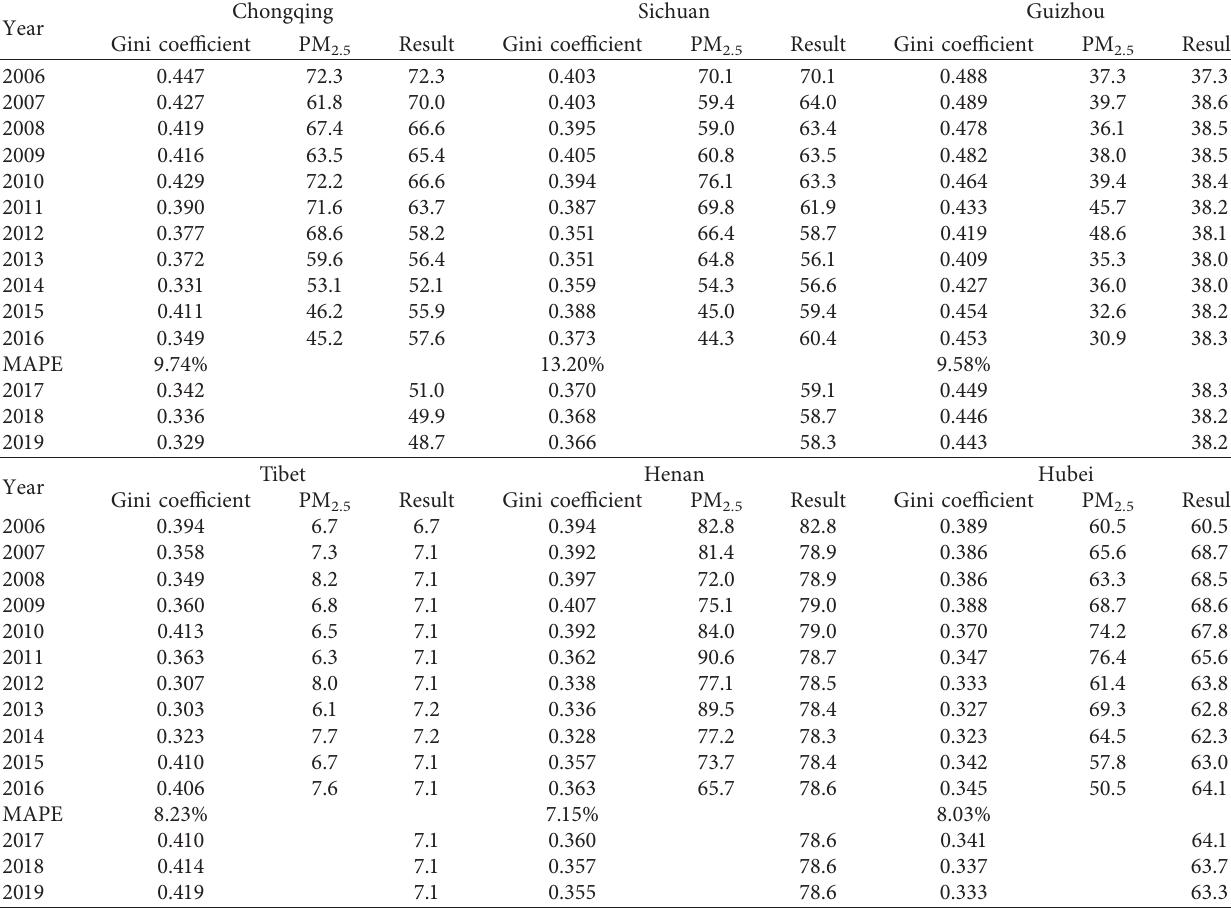
Table 6: Fitting results of the PM 2.5 concentrations in southwest and central China.